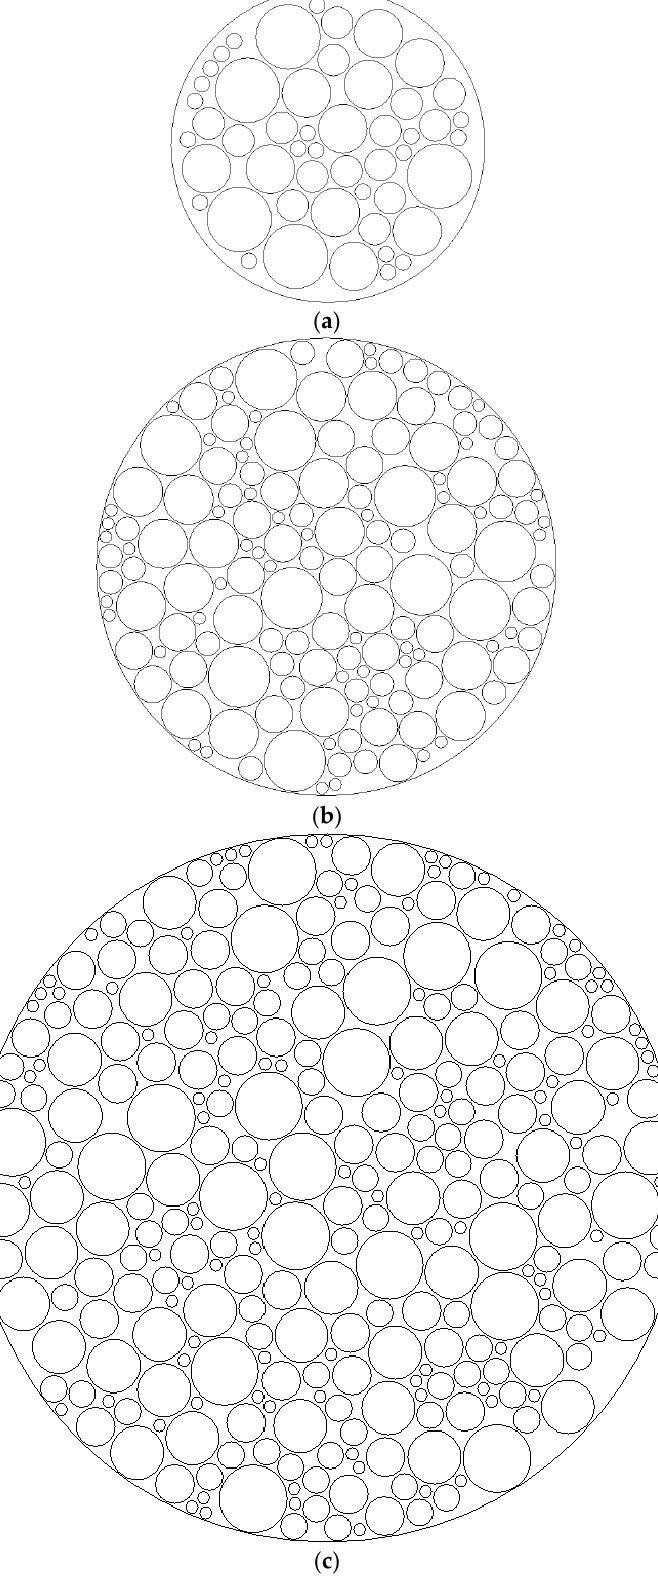
Figure 6. Locally optimal layouts of circles in DCBP: ( a ) n = 50, r * = 182.6996, CPU 1355.85 s for 100 runs; ( b ) n = 150, r * = 368.4018, CPU 45,910.3 s for 50 runs; ( c ) n = 300, r * = 520.5562, CPU 24,185.24 s for 50